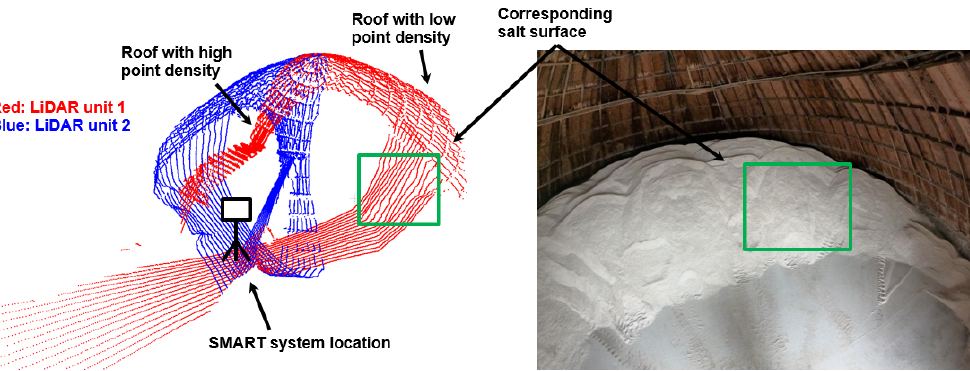
Figure 4. A sample point cloud (colored by LiDAR unit ID) and image captured by the SMART system at a given scan.